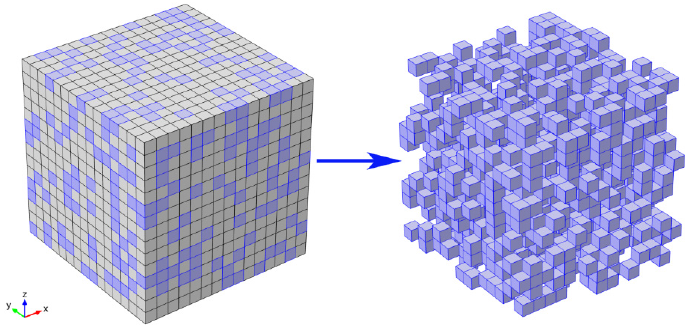
Figure 1. Schematic of solid oxide fuel cells (SOFC) electrode microstructure; blue is pore phase, gray denotes solid phase.